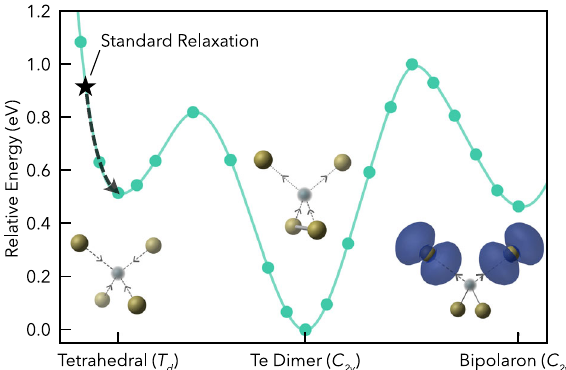
Fig. 1 Potential energy surface for the neutral cadmium vacancy in CdTe, illustrating the global minimum (Te dimer) and local minima (Bipolaron and Tetrahedral con fi gurations). A standard optimisation from the initial, high-symmetry con fi guration (black star) gets trapped in the metastable Tetrahedral con fi guration. Adapted from Matter , I. Mosquera-Lois and S.R. Kavanagh, In Search of Hidden Defects (2021) with permission from Elsevier.